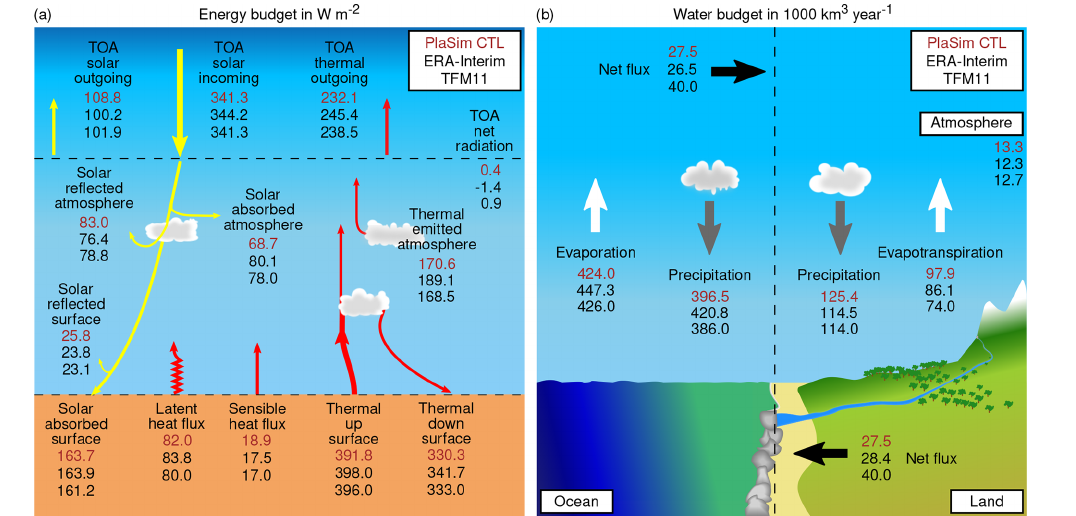
Figure 2. Global average annual mean energy (a) and water (b) budgets for the CTL simulation compared with ERA-Interim and Trenberth et al. (2011). Units are shown in the title of each